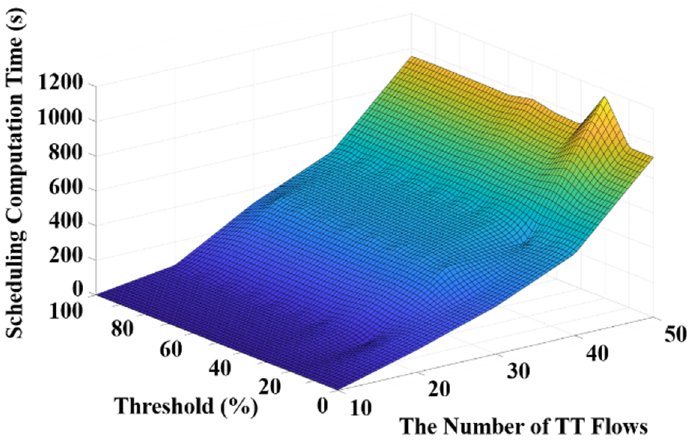
Figure 9. The computation time in scheduling with thresholds and numbers of flows.